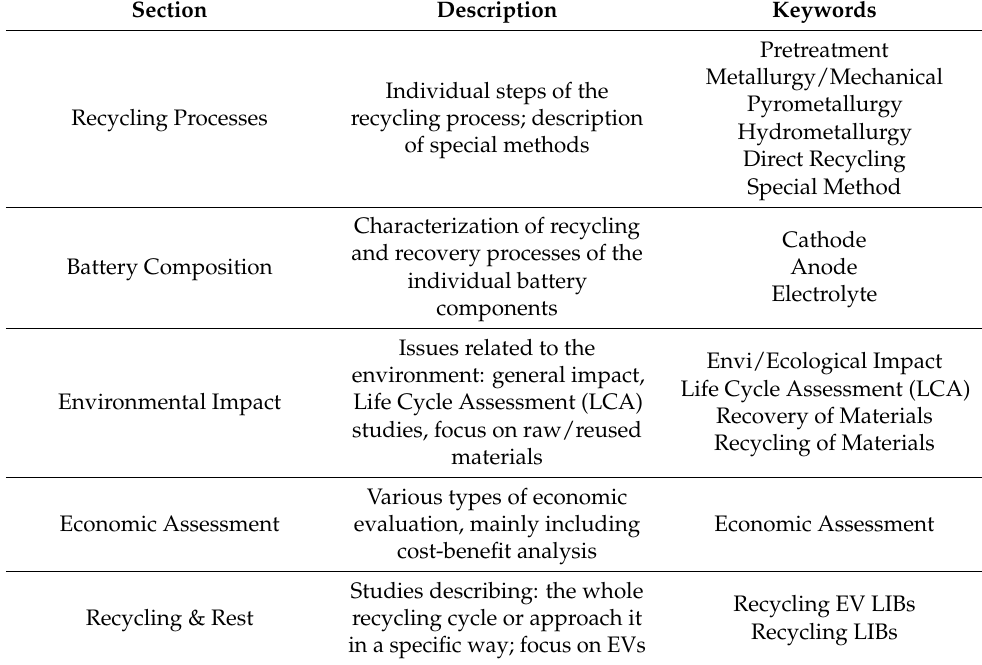
Table 1. Keywords, the selection criteria for resulting publication of database search. Section